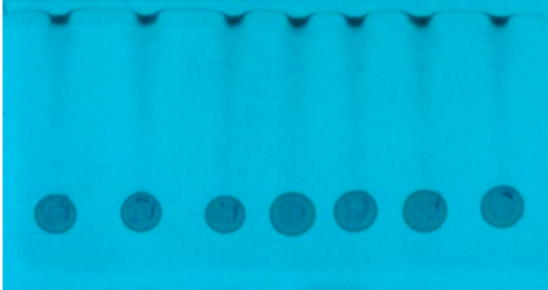
Figure 5. The serum sample chromatograms after development using SPK3 procedure; stationary phase. HPTLC Silica gel 60 F254 (Merck), mobile phase: methanol.